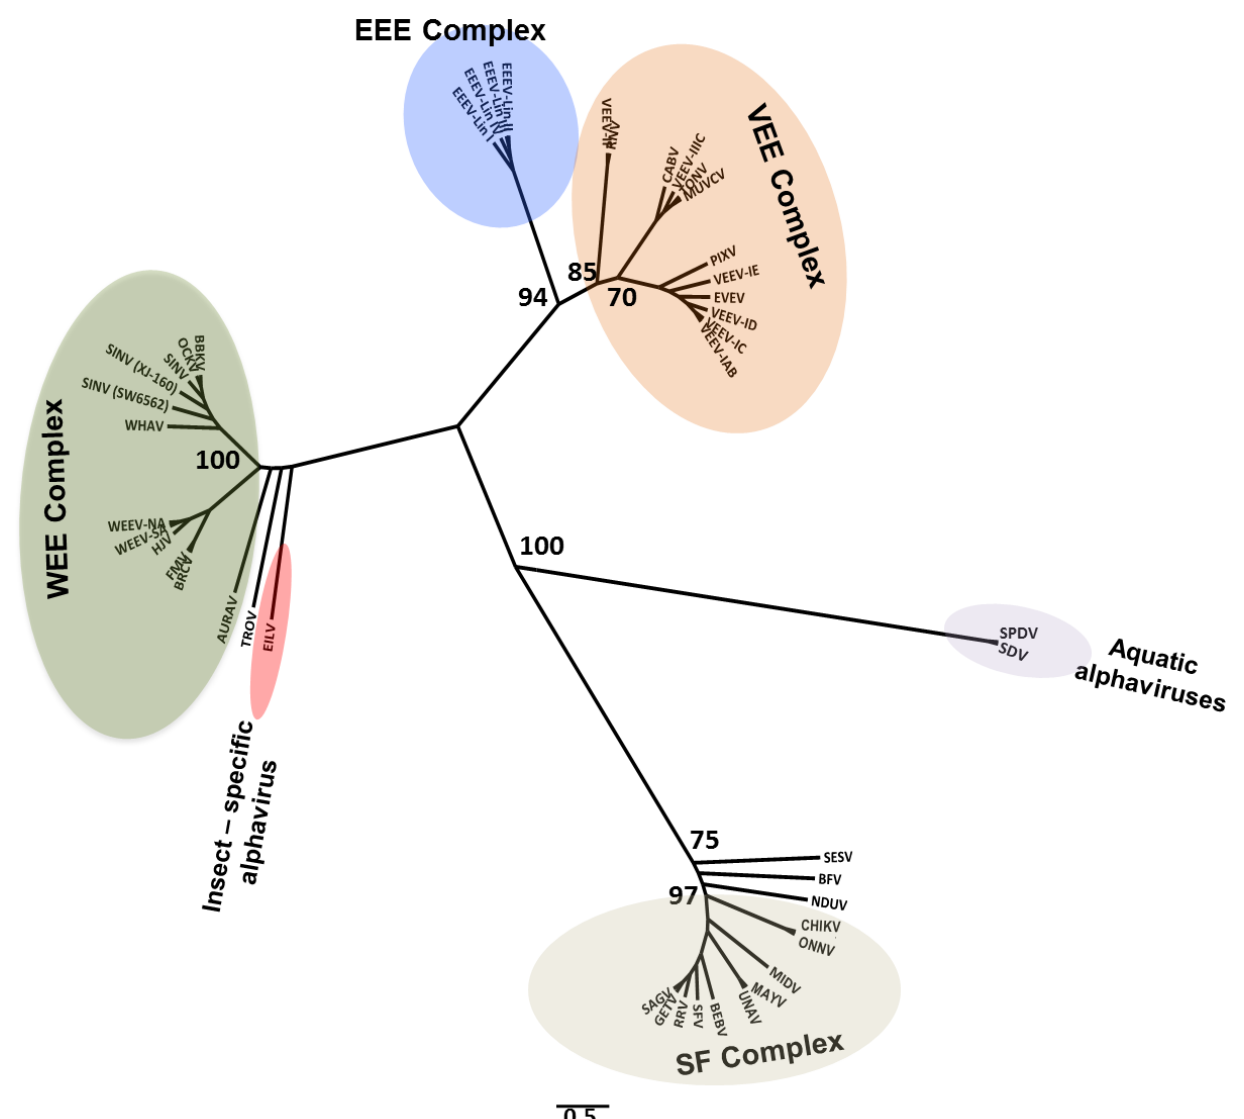
Figure 6. Togaviruses: Maximum likelihood analysis of select togaviruses. Phylogenetic tree based on nucleotide sequences of the alphavirus structural ORF. Branch labels indicate virus abbreviation/strain. Additional virus isolate information is contained in a supplemental file.